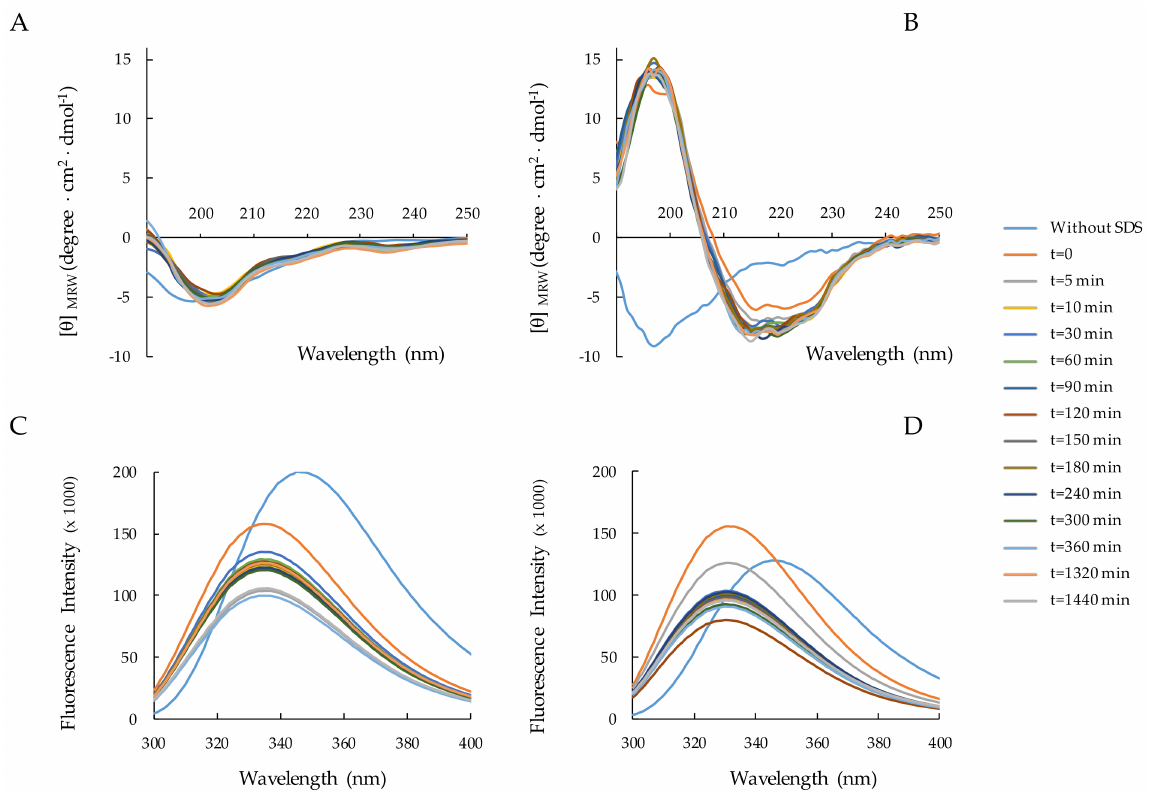
Figure 4. CD and fluorescence spectra of RiLK1 and 1018-K6. RiLK1 ( A , C ) and 1018-K6 ( B , D ) were analyzed as a function of time. Spectra were recorded at a peptide concentration of 50 µ M in 150 mM SDS, at pH 4.0 and at 25 ◦ C after up to 24 h incubations. Spectra of peptides 50 µ M in water, without SDS (blue lines), were also